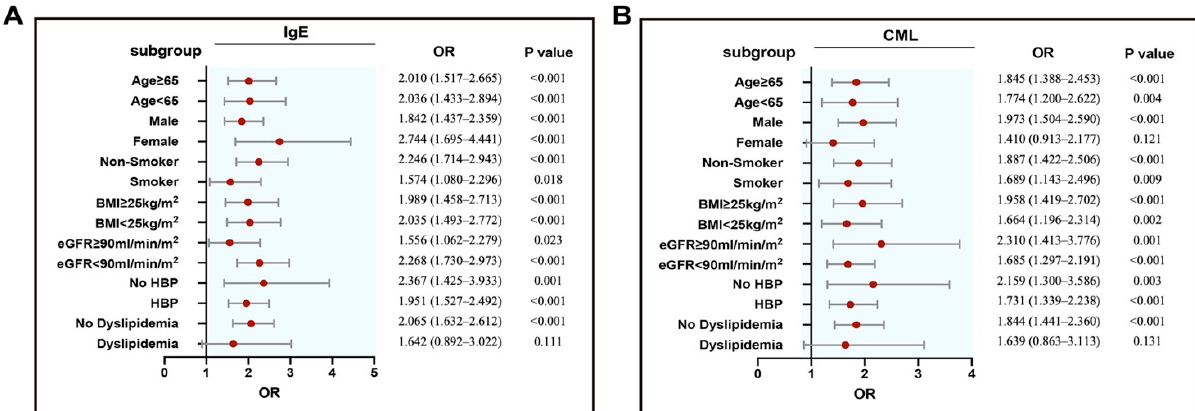
Figure 3. Forest plots (unadjusted) to analyze the predictive value of IgE ( A ) or CML ( B ) for ISR in different subgroups of T2DM patients. IgE or CML was included as a log- transformed continuous variable. BMI: body mass index; eGFR: estimated glomerular filtration rate; HBP: high blood pressure; ISR: in-stent restenosis; T2DM: type 2 diabetes mellitus. ROC curves showed that the addition of IgE or CML to the basic clinical model Table 3. Uni- and multi-variant regression models.